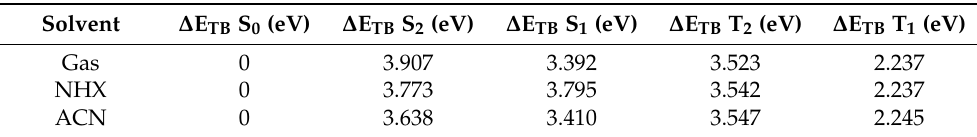
Table 4. The differences in total bonding energies are calculated at the optimized geometries of the states with the TZ2P basis and the CAMY-B3LYP functional with the default parameters for range separation, relative to the ground state in the solvent.